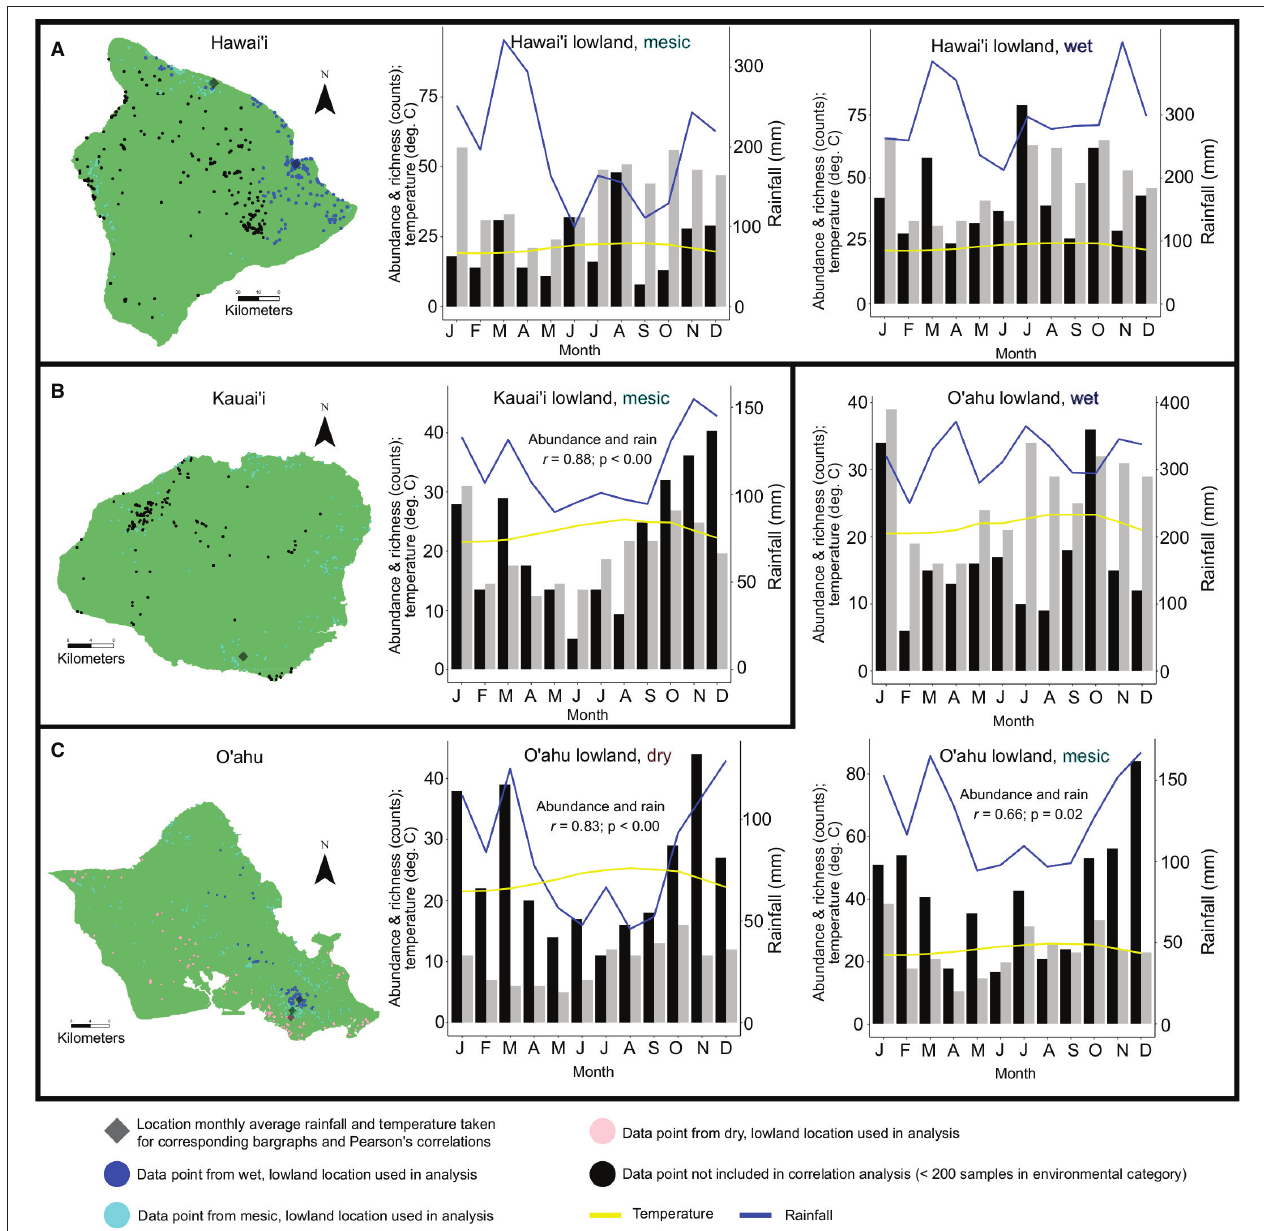
FIGURE 3 | Examination of abundance data with ≥ 200 observations and/or collections and richness data on an island within annual rainfall and elevation categories by average monthly rainfall and temperature. Datapoints are color coded by annual rainfall and elevation categories. The closest climate station to the highest density of data points for a given category that was used to determine average monthly rainfall and temperature is indicated. Histograms show abundance (black), richness (gray), average monthly rainfall (blue) and temperature (yellow) for: Hawai‘i Island, lowland wet and lowland mesic habitats (A) ; Kaua‘i Island, lowland mesic habitats (B) ; O‘ahu Island, lowland wet, mesic, and dry habitats (C) . Pearson’s correlation coefficients between richness and abundance counts and average monthly rainfall or temperature that were found to be significant ( p < 0.05) are indicated in histogram panels.